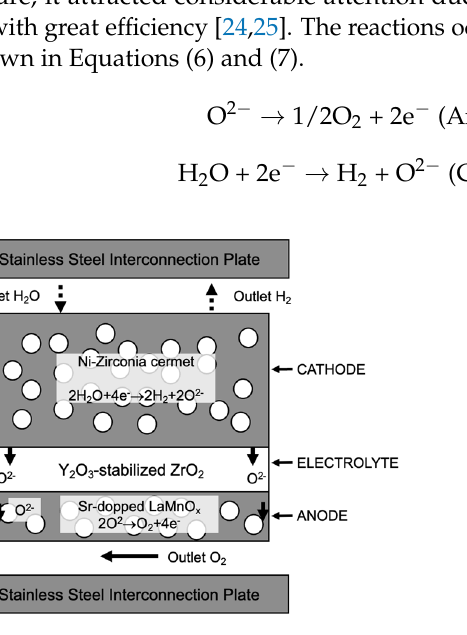
Figure 3. Scheme for PEMEL, proton exchange membrane electrolysis [22,23]. Reprinted with per- mission from [22].